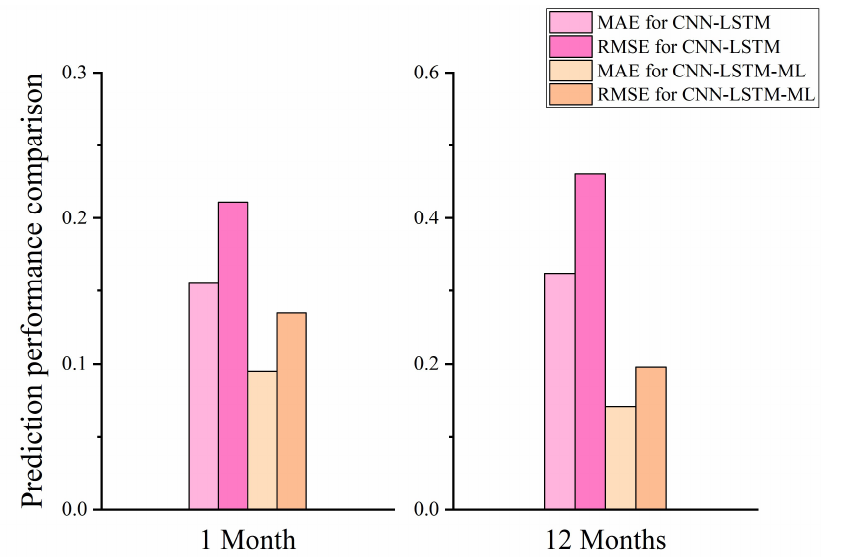
Figure 10. Comparison of short-term and long-term predictive performance of CNN-LSTM and CNN-LSTM-ML.